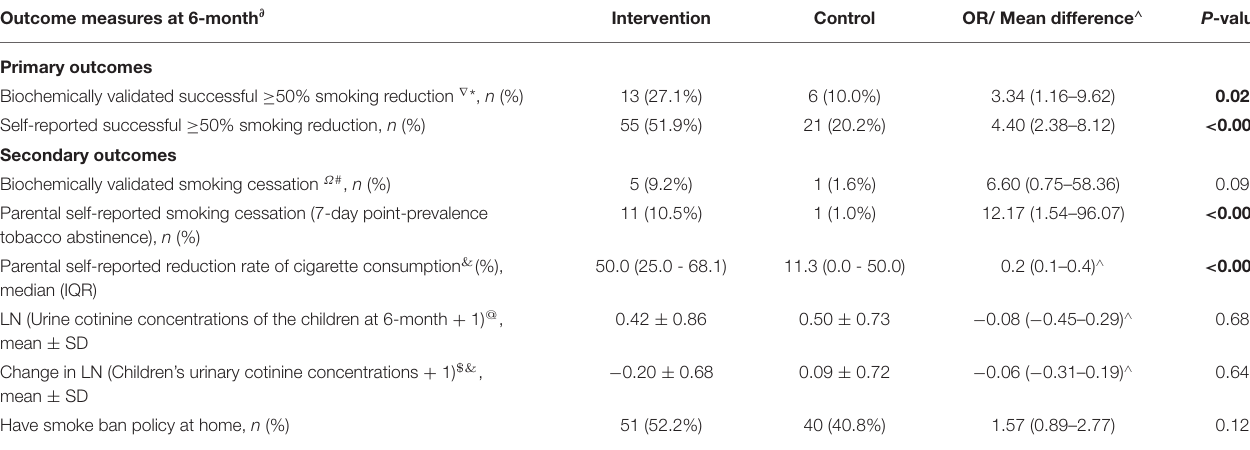
TABLE 3 | Primary and secondary outcomes. Outcome measures at 6-month ∂ Intervention Control OR/ Mean difference ∧ P -value Primary outcomes